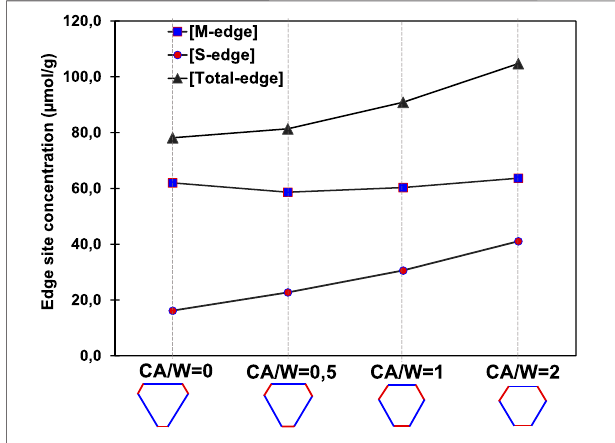
FIGURE 5 | M-edge, S-edge and total edge sites concentrations determined from low temperature CO adsorption on sul fi ded W(CA/W (cid:1) x)/ Al 2 O 3 catalysts. Below the graphic is presented the slab morphology according to the M-edge/S-edge